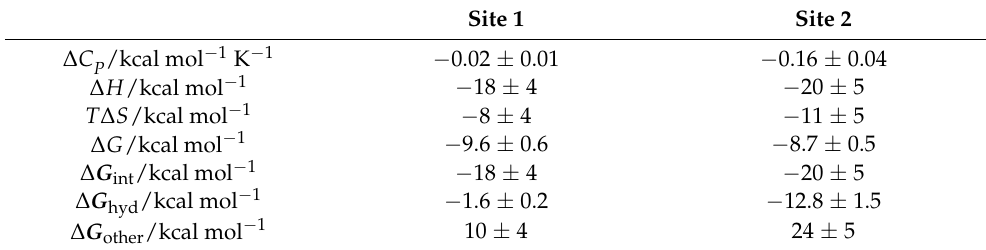
Table 2. Standard thermodynamic parameters of 360A binding to 22GT ( T = 25 ◦ C, [K + ] = 100 mM) and the corresponding specific contributions to ∆ G estimated as shown in the